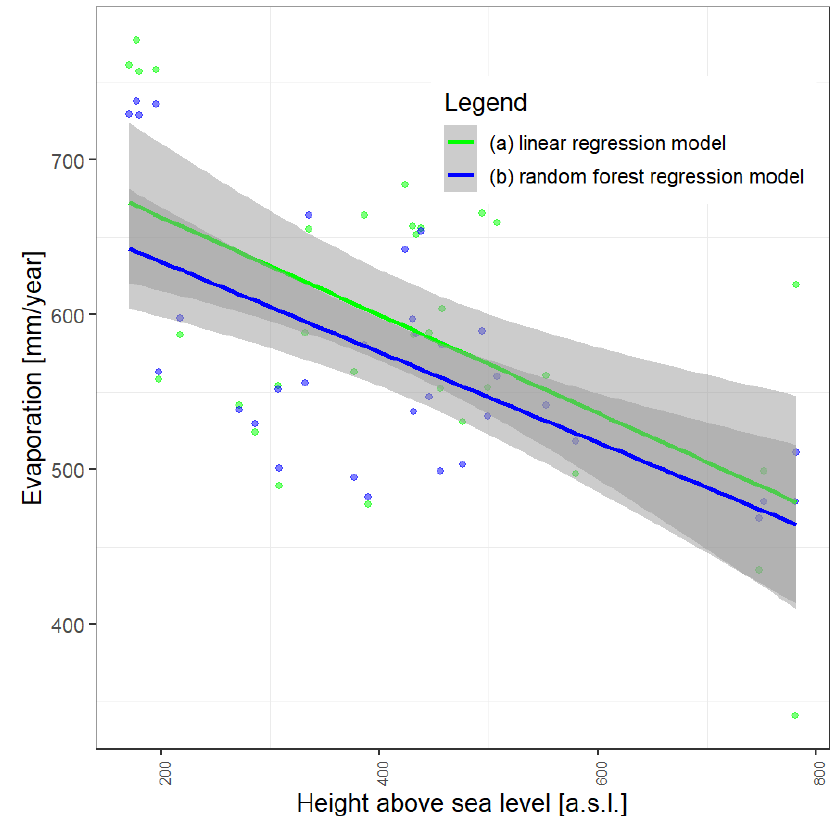
Figure 6. The lines (a) and (b) represent the relationship between yearly total evaporation and elevation based on the derived formulas. The points represent yearly evaporation and altitude for both